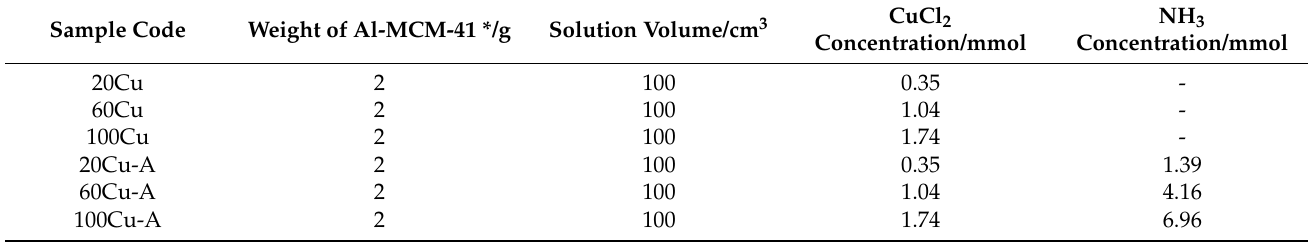
Table 1. The sample codes and amounts of reactants used for their synthesis.